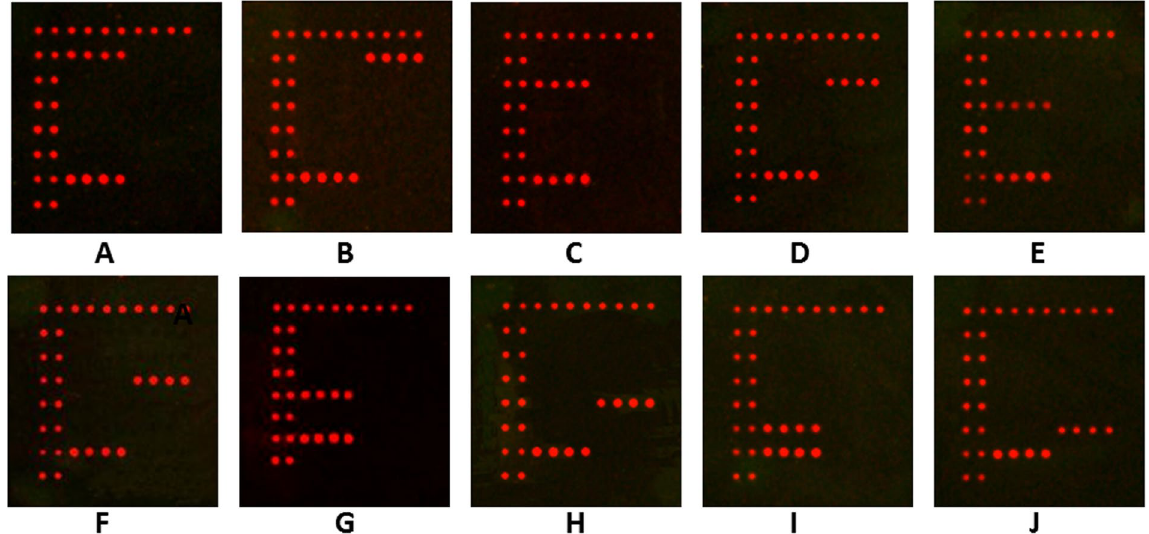
Figure 2. Microarray scanning results for the 10 species of Liposcelis . ( A ) Scanning result for hybridization with the ITS2 sequence from L. brunnea , which were collected from Prague in Czech Republic or the United states (USA). ( B ) Scanning result for hybridization with the ITS2 sequence from L. entomophila , which were collected from Beijing, Chongqing, Wuhan (Hubei Province) in China, or Prague in Czech Republic. ( C ) Scanning result for hybridization with the ITS2 sequence from L. decolor , which were collected from Chongqing in China, Prague in Czech Republic or the USA. ( D ) Scanning result for hybridization with the ITS2 sequence from L. pearmani , which were collected from the USA. ( E ) Scanning result for hybridization with the ITS2 sequence from L. rufa , which were collected from the USA. ( F) Scanning result for hybridization with the ITS2 sequence from L. mendax , which were collected from Jiangsu Province in China. ( G ) Scanning result for hybridization with the ITS2 sequence from L. bostrychophila , which were collected from Beijing, Guangxi, Chongqing in China, Prague in Czech Republic, or Manhattan in the USA. ( H ) Scanning result for hybridization with the ITS2 sequence from L. corrodens , which were collected from Prague in Czech Republic, or the USA. ( I ) Scanning result for hybridization with the ITS2 sequence from L. paeta , which were collected from Shijiazhuang (Hebei Province), Zhejiang Province, Wuhan (Hubei Province) in China, Prague in Czech Republic, or the USA. ( J ) Scanning result for hybridization with the ITS2 sequence from L. tricolor , which were collected from Heze (Shandong Province) in China.